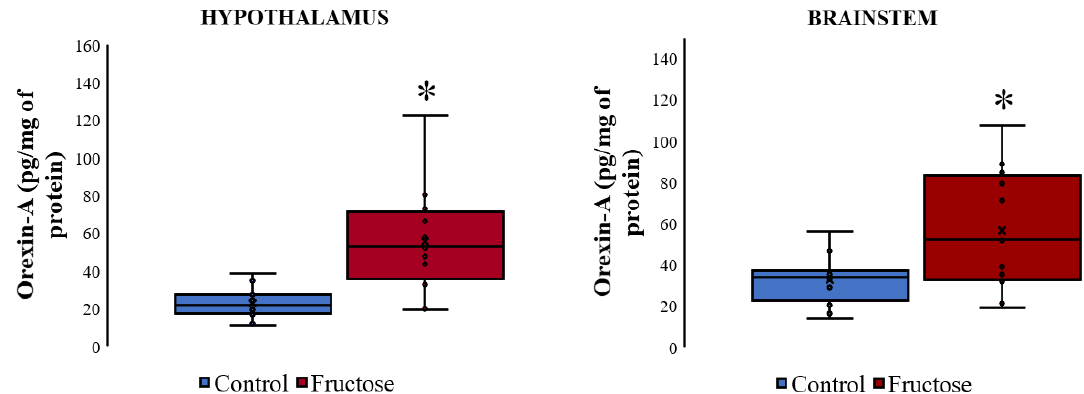
Figure 4. Brain levels of orexin A after feeding the rats with 10% fructose diet for five weeks. Box plots represent the median, interquartile range, and minimum and maximum values. N = 6 per group. The differences between the groups were analyzed with a Mann–Whitney rank sum test (* p < 0.05 vs. control group).